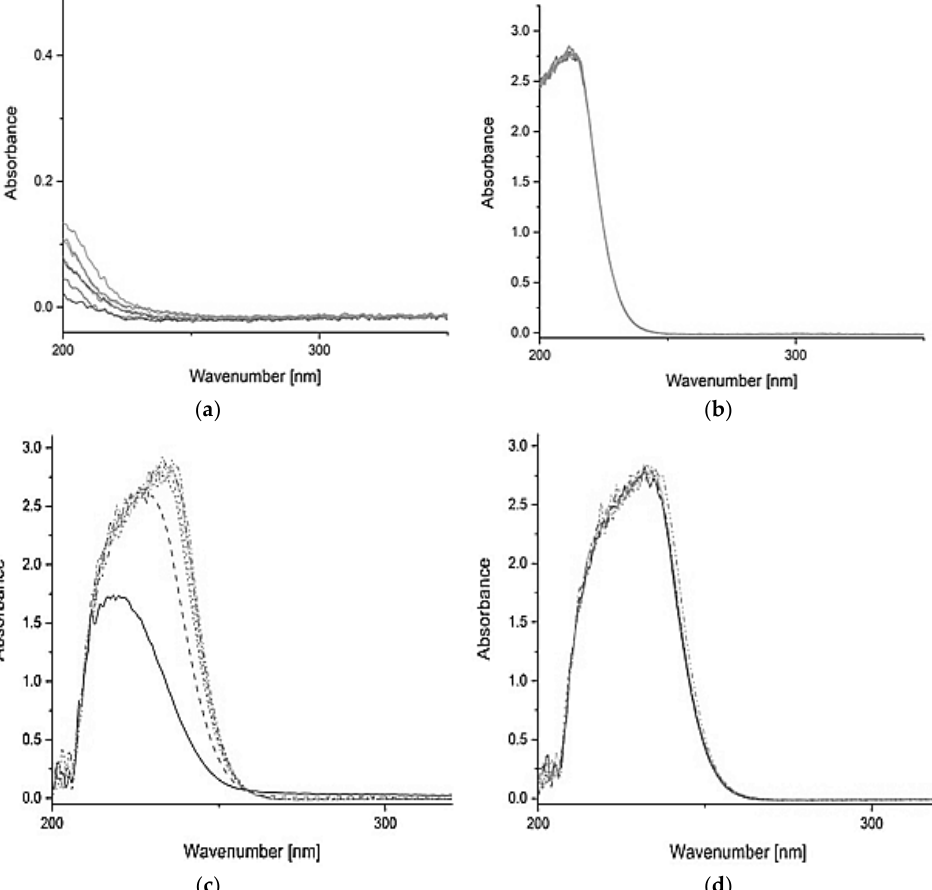
water, ( d ). In spectrum ( c ) and ( d ) 0D and 0K stand for non-treated and not saturated deionized and tap